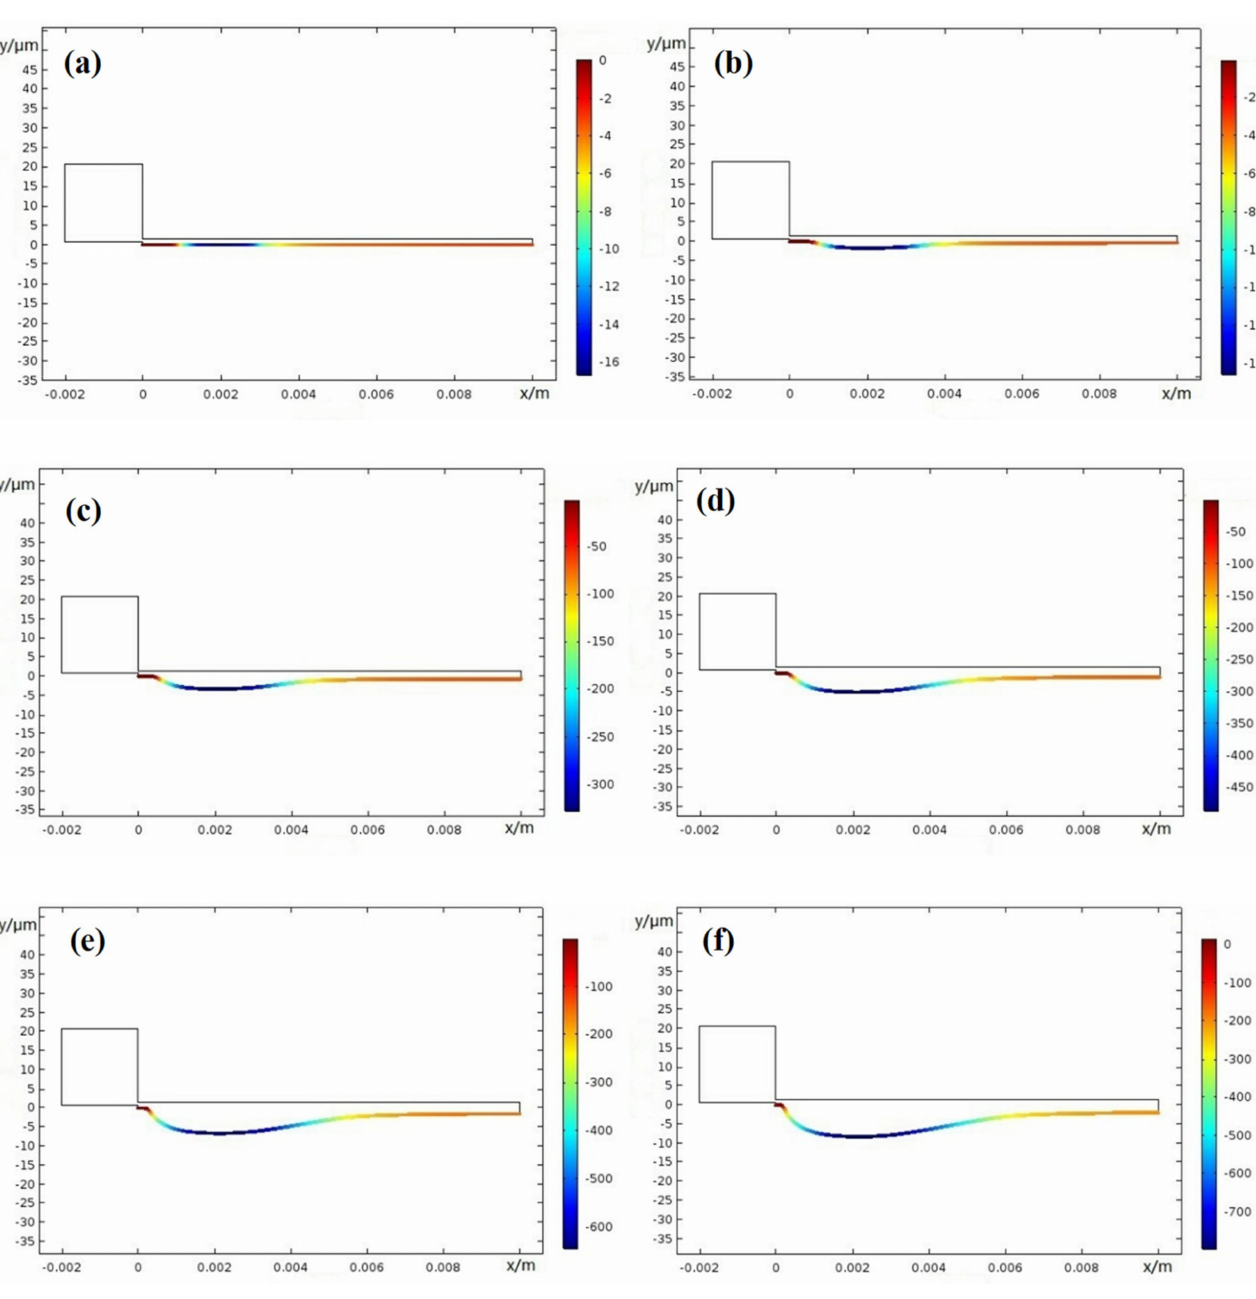
Figure 16. Damage evolution of X100 steel crevice corrosion at width W = 0.15 mm: ( a ) 0 weeks; ( b ) 10 weeks; ( c ) 20 weeks; ( d ) 30 weeks; ( e ) 40 weeks; ( f ) 50